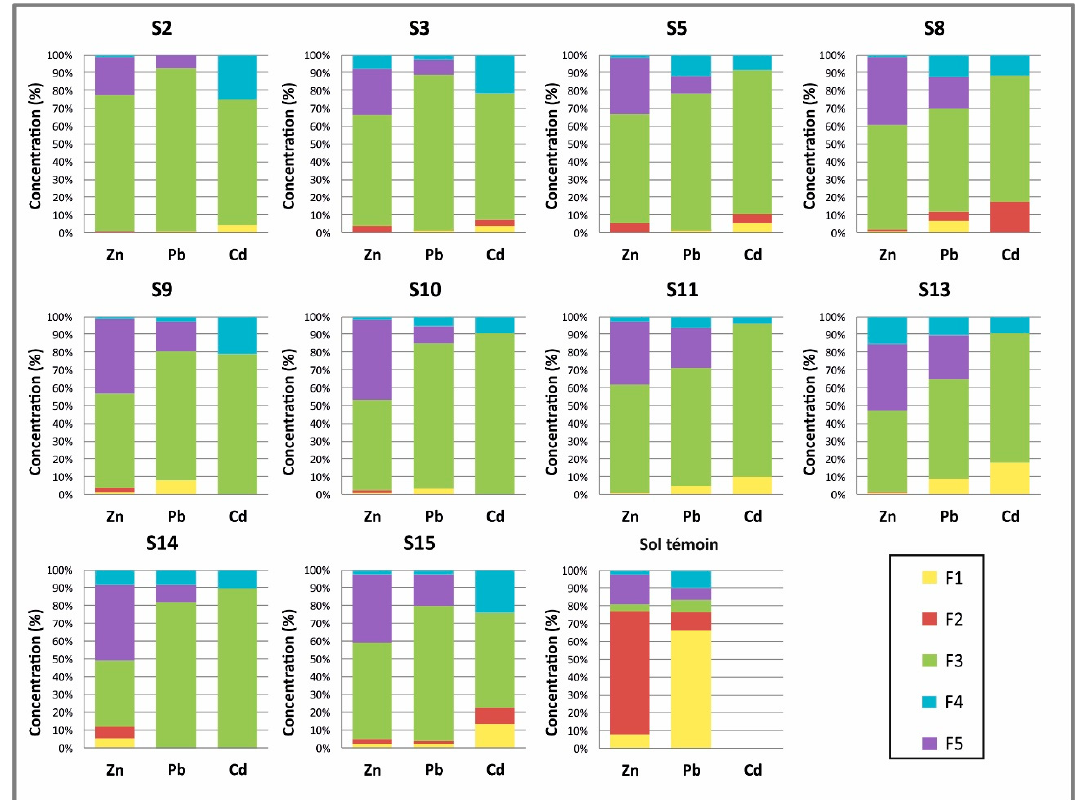
Figure 3. Proportions of the fractions upon sequential extraction of the soil samples (S). F—fractions extracted (F1, F2, F3, F4 and F5).